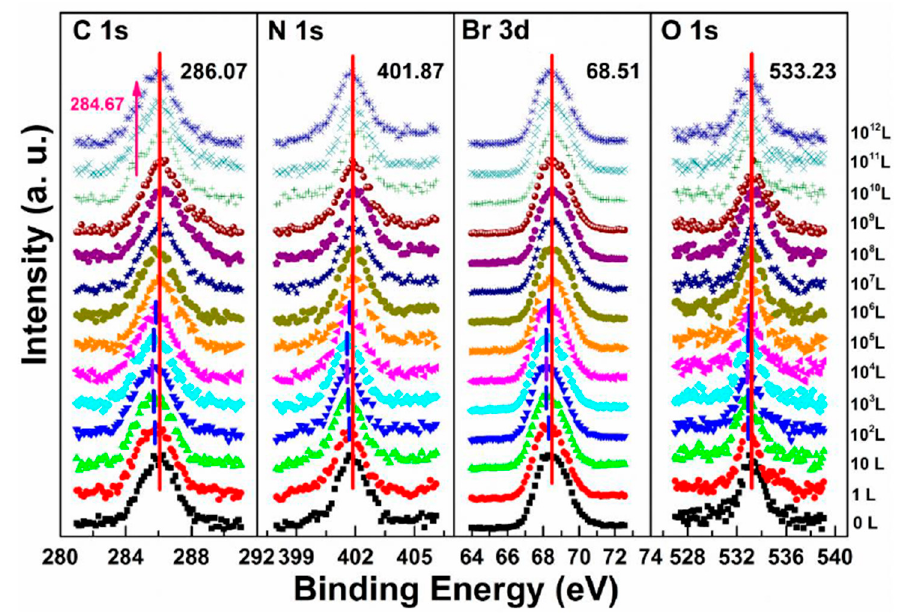
Figure 8. Evolutions of C 1s, N 1s, Br 3d, and O 1s XPS spectra of cleaved MAPbBr 3 single crystal under N 2 exposures. From Ref. [38]. with permission.